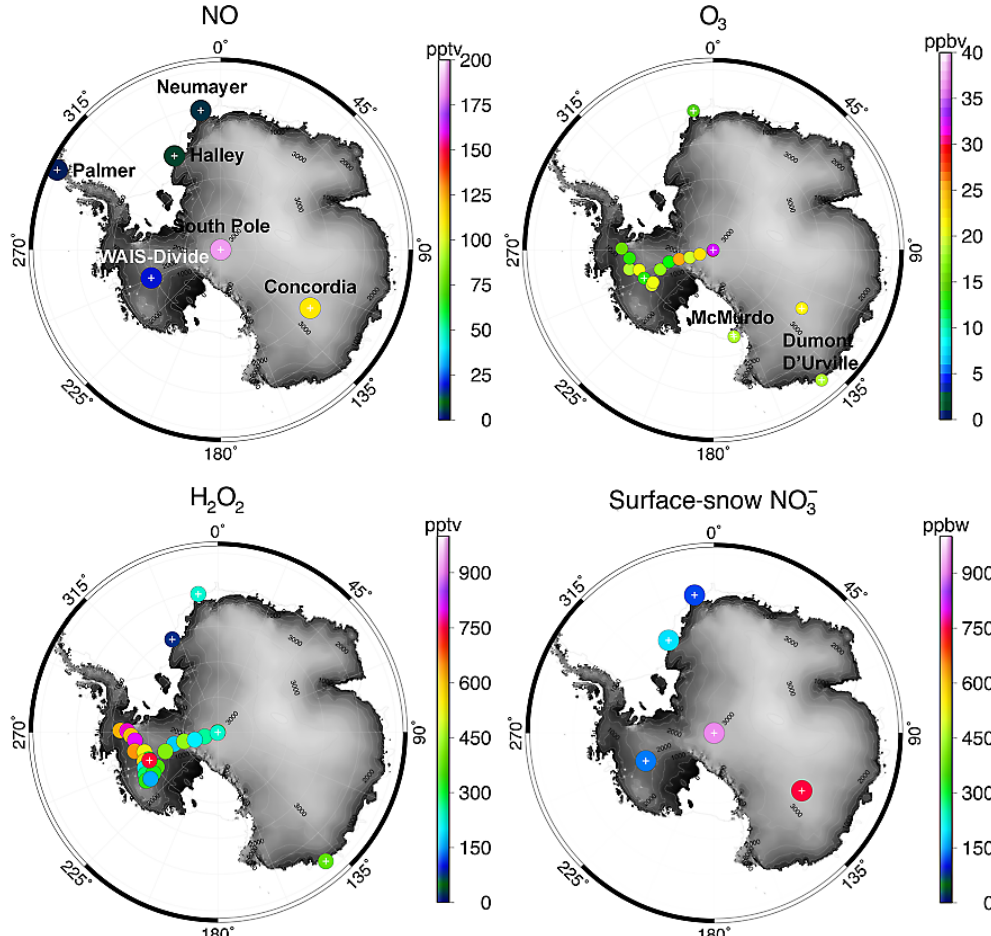
Fig. 3. Report of some previous Antarctic measurements of atmospheric NO, surface O 3 , H 2 O 2 , plus NO − et al. (2013), Preunkert et al. (2012), Frey et al. (2009a), Legrand et al. (2009), Frey et al. (2005), Dibb et al. (2004), Davis et al. (2004), Rothlisberger et al. (2000), Jacobi et al. (2000), Jones et al. (1999), Mulvaney et al. (1998), Jefferson et al. (1998), NOAA/GMD, and AWI